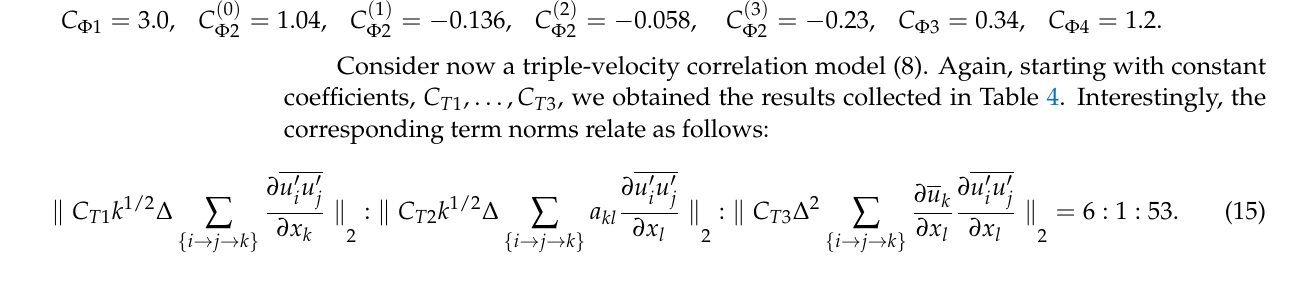
Table 4. Coefficients in the constant coefficient model (8).